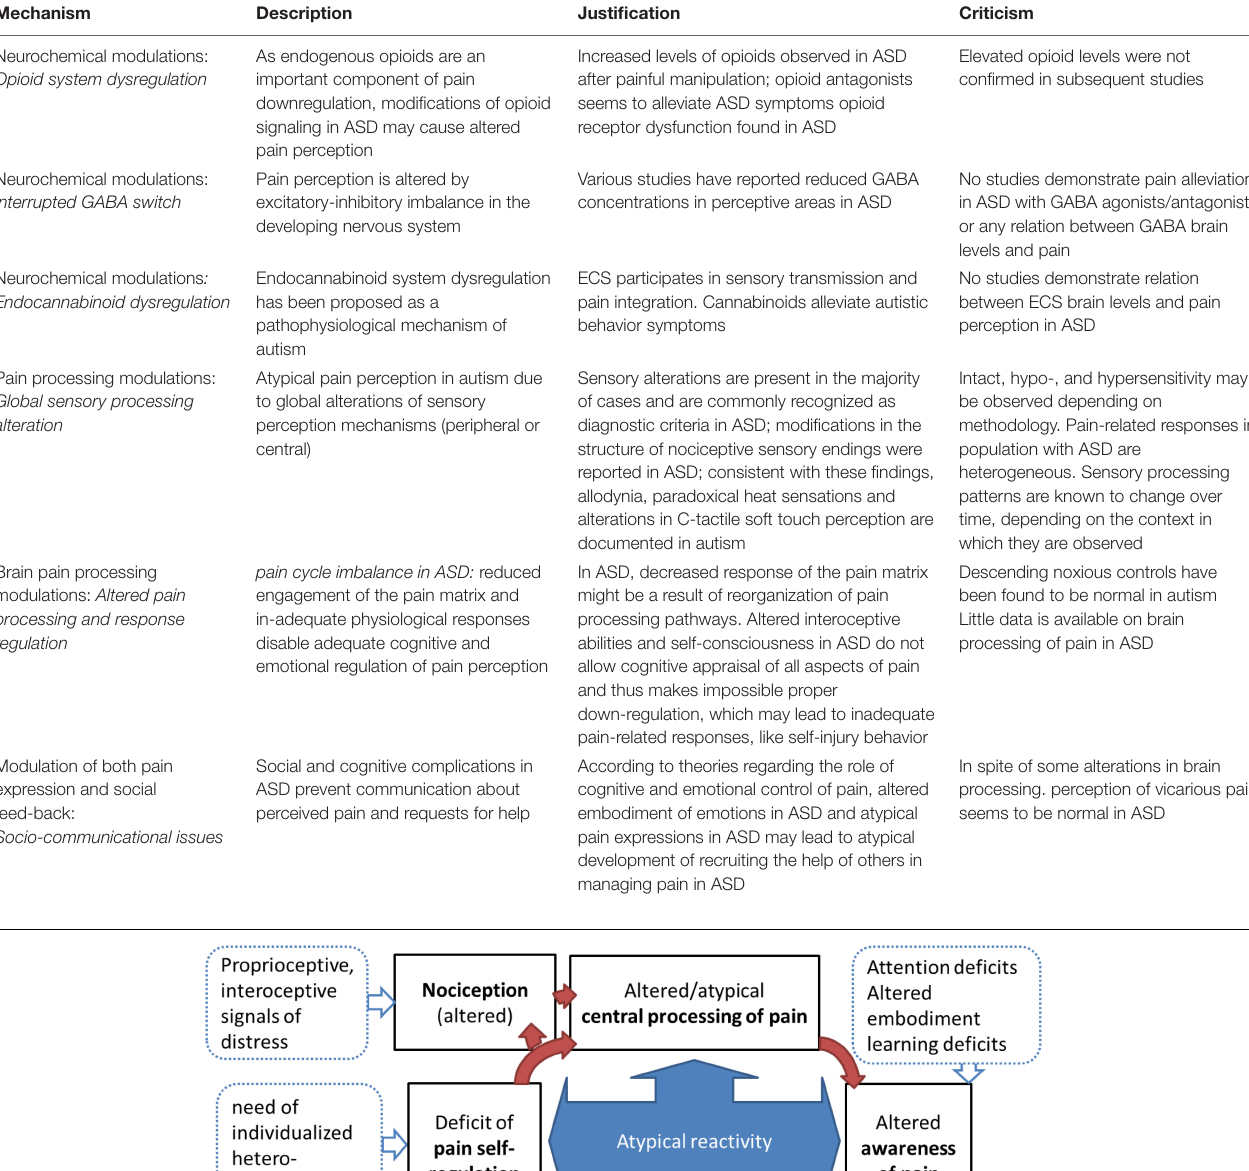
TABLE 1 | Summary and discussion of mechanisms involved in both ASD and pain dysregulation. Mechanism